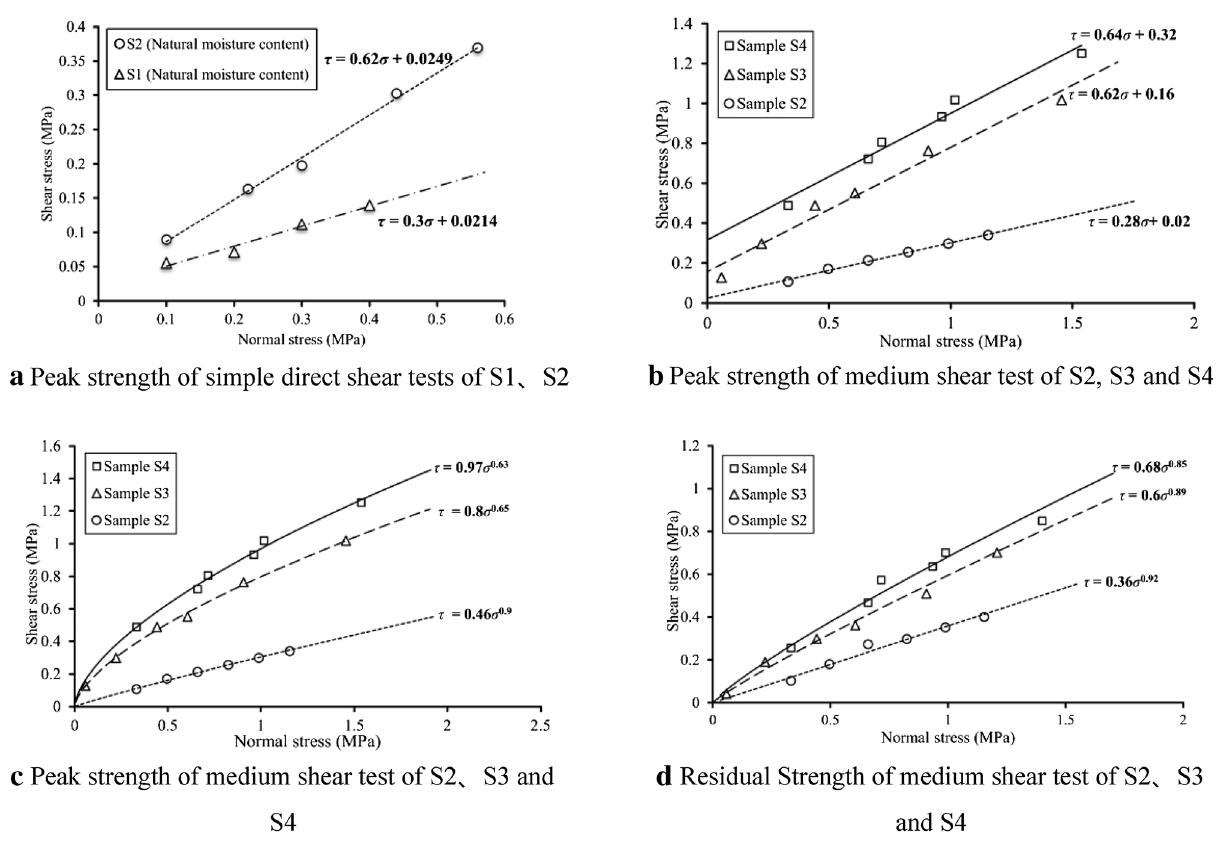
Figure 8. Strength envelope of indoor direct shear